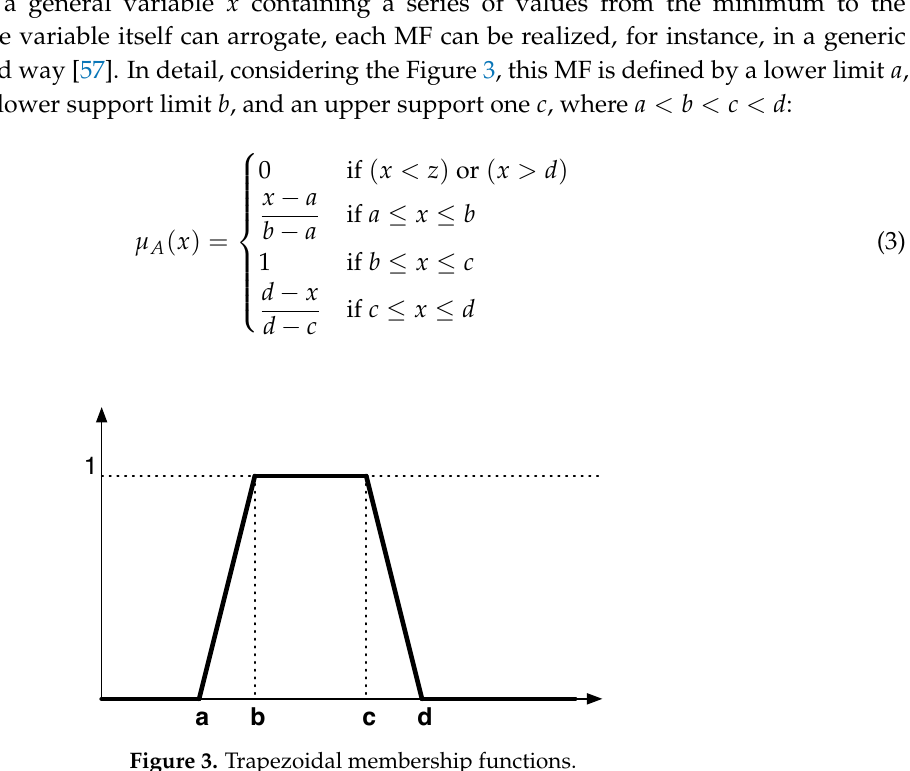
Figure 3. Trapezoidal membership